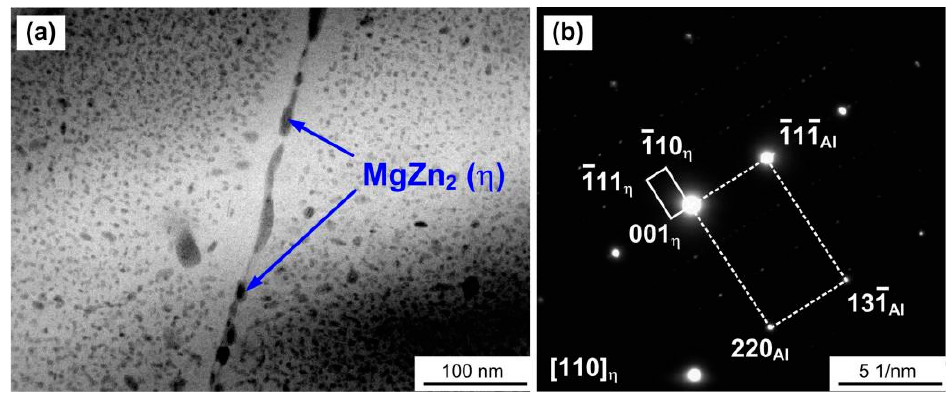
Figure 4. TEM microstructure of the 7075-T73 aluminum alloy: ( a ) bright-field image and ( b ) electron diffraction pattern of grain boundary precipitates.